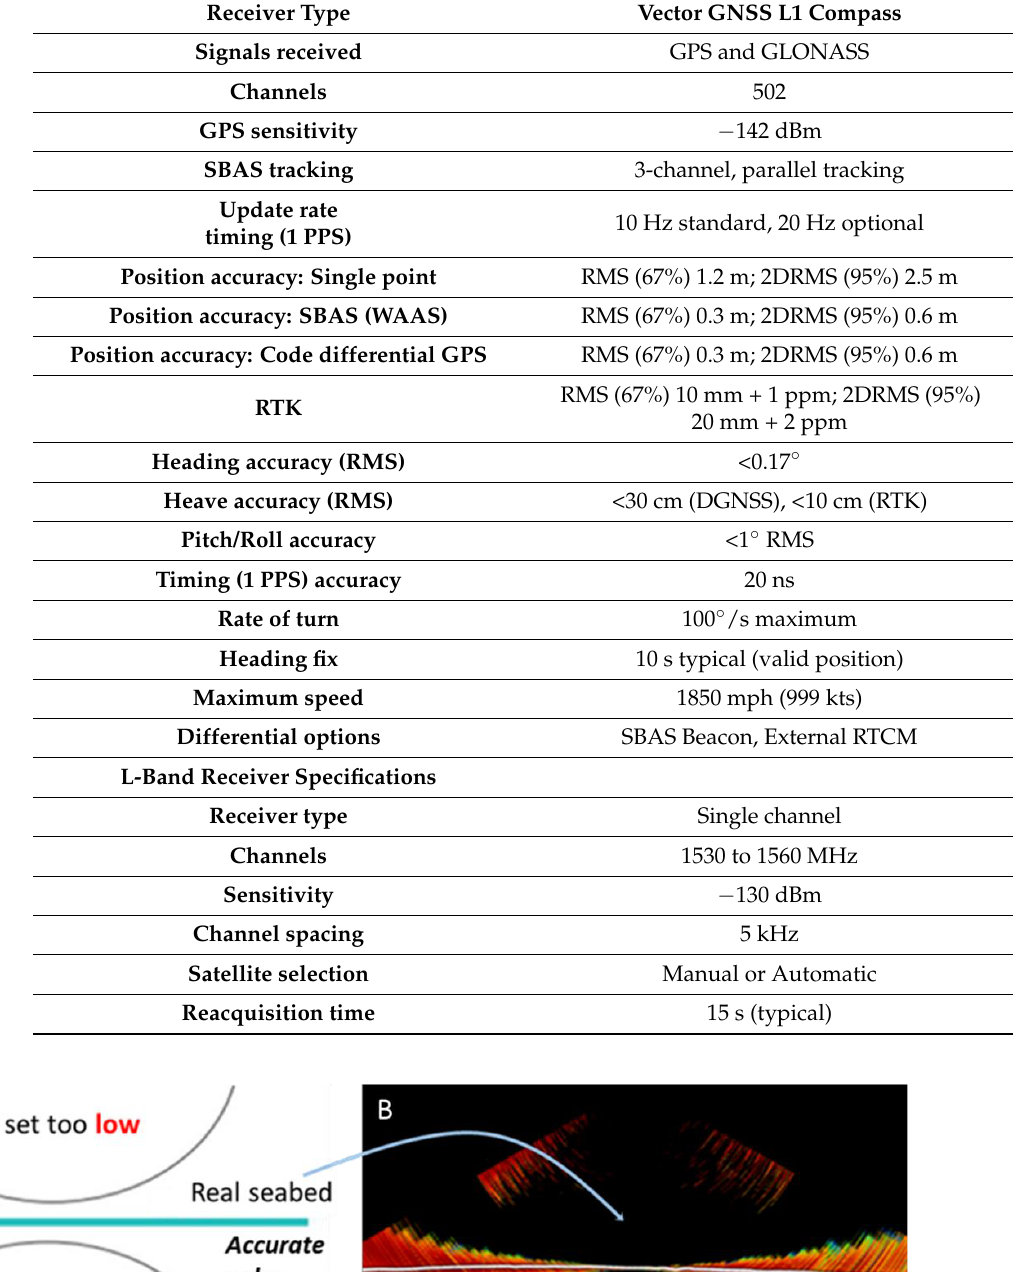
Table 2. The GNSS sensor specifications.